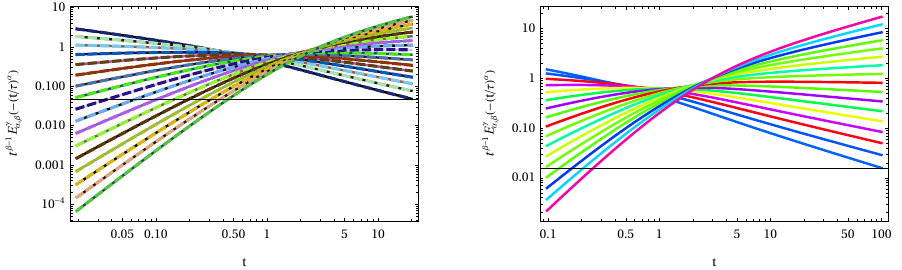
Figure 18. A variety of solutions with β = 2 αγ for different values of γ . The solid line represents the SG inverse Laplace result, while the dashed lines are the series approximation of t β − 1 E γ using 126 terms. The limitation on the left panel for the range results from using the series repre- sentation and the bad convergence for large arguments. The right panel shows the same SG inverse Laplace transform on a wider range. Parameters are χ 0 = 1, τ = 1, α = 4/5, and γ is taken from [2/5,2] in steps of 1/10. The number of Sinc points is N =